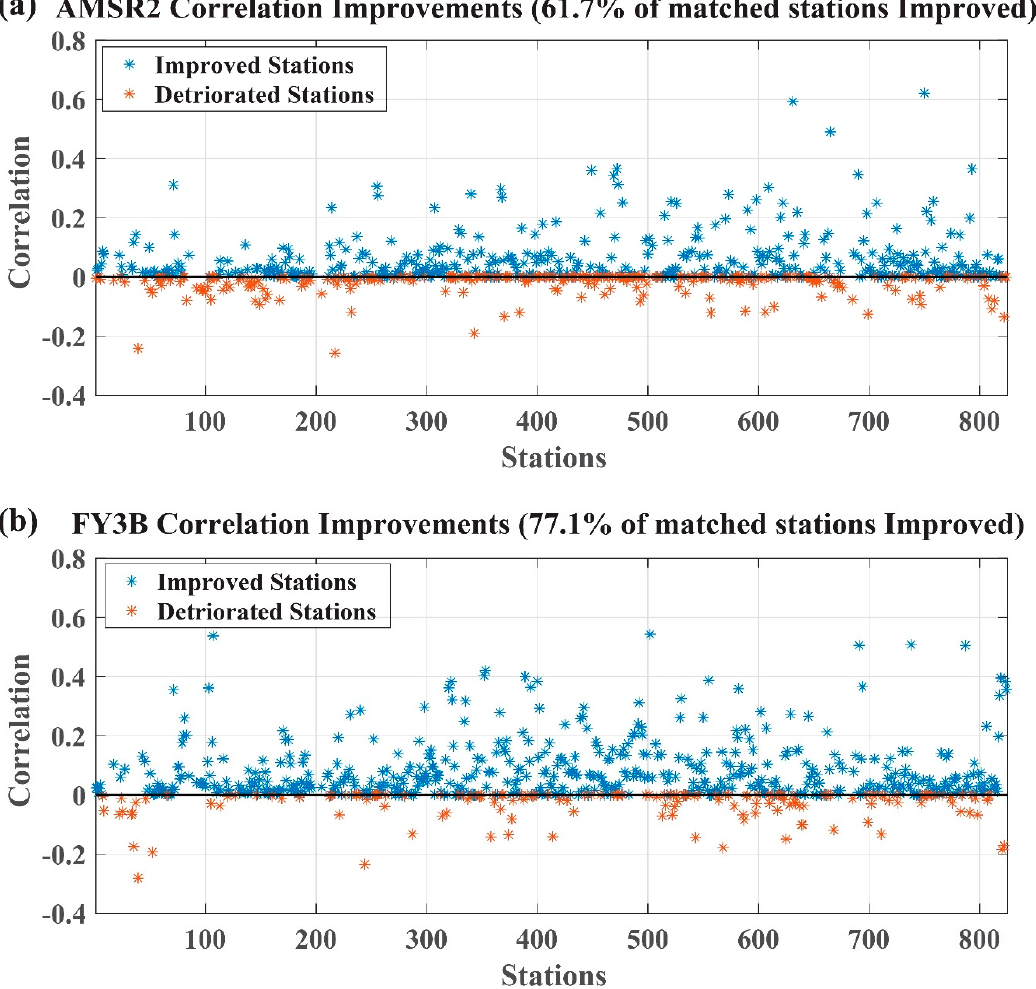
Figure 8. Contributions (change in correlation coefficients-either improvements or deterioration) of ( a ) the Advanced Microwave Scanning Radiometer 2 (AMSR2) and ( b ) Fengyun-3B (FY3B) in the merging scheme relative to verifications based on the in situ datasets. Blue points show improvements and red points show deteriorations.